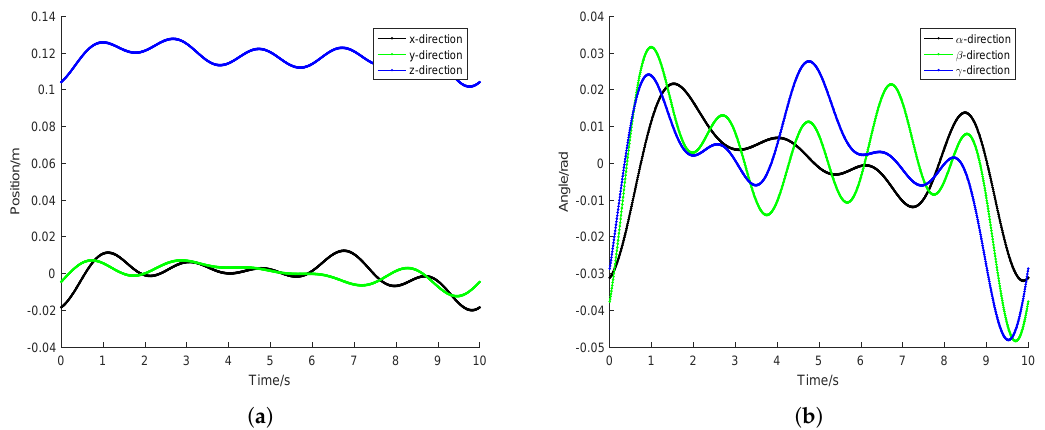
Figure 11. Optimal exciting trajectory. ( a ) Positional trajectory; ( b ) Angular